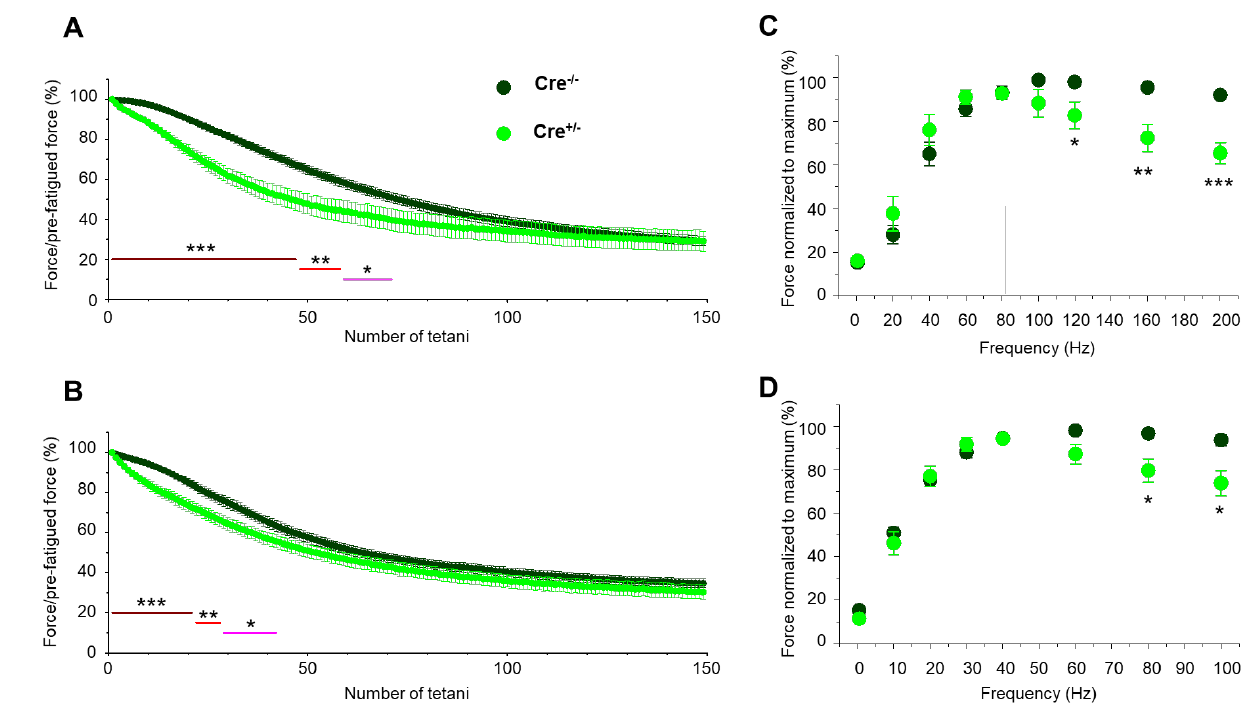
Figure 3. Altered fatigability and activation of EDL and SOL muscles in Cre +/ − mice. Fatigue in EDL (A) and in SOL (B) muscles from Cre −/− (N = 13) and Cre +/− (N = 14) mice. Magenta, red, and dark red line show the interval where Cre +/− data is significantly different from Cre −/− at p < 0.05, p < 0.01, and p < 0.001, respectively. Force-frequency relationship in EDL (C) and in SOL (D) muscles from Cre −/− ( N = 4) and Cre +/− ( N = 4) mice. * p < 0.05, ** p < 0.01, *** p < 0.001. Taken together, the in vivo and in vitro force measurements suggest that CB1 funda- mentally contributes to the normal skeletal muscle force production and performance in mice.